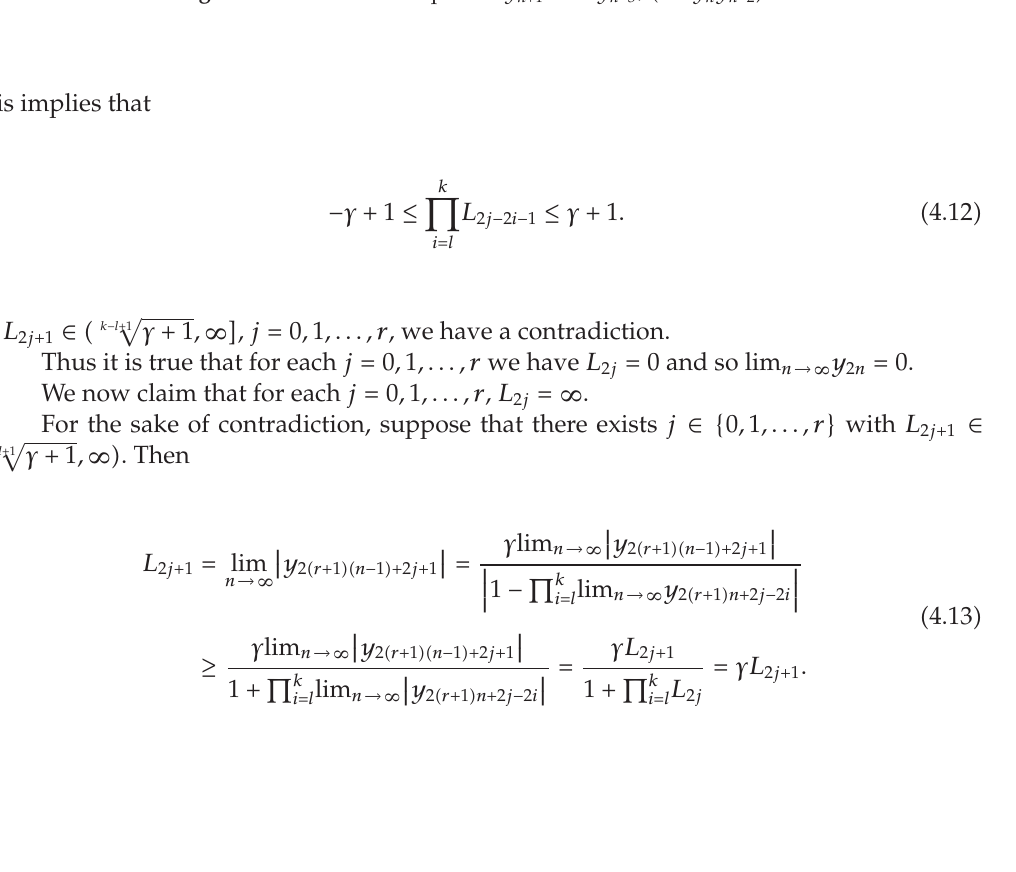
Figure 2: The di ff erence equation y n (cid:3) 1 (cid:4) 0 . 7 y n − 3 / (cid:5) 1 − y n y n − 2 (cid:6)